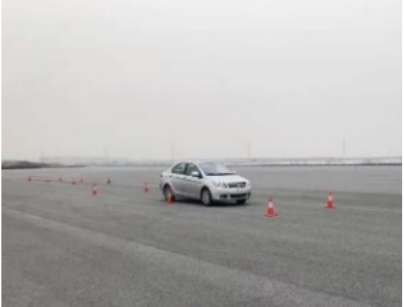
Figure 6. Testing vehicle.